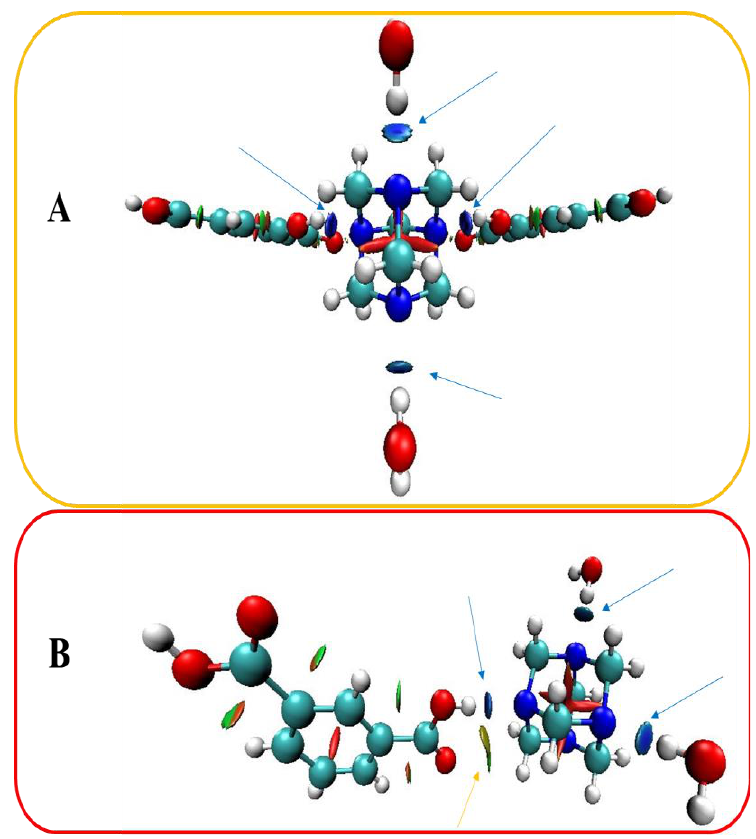
Figure 6 . Non-covalent interaction surfaces regarding compound 2 ( A ) and compound 1 ( B ); blue arrows indicate the specific strong hydrogen bonds, while the green arrow highlights the intermolecular electrostatic interactions in the long-range regime.